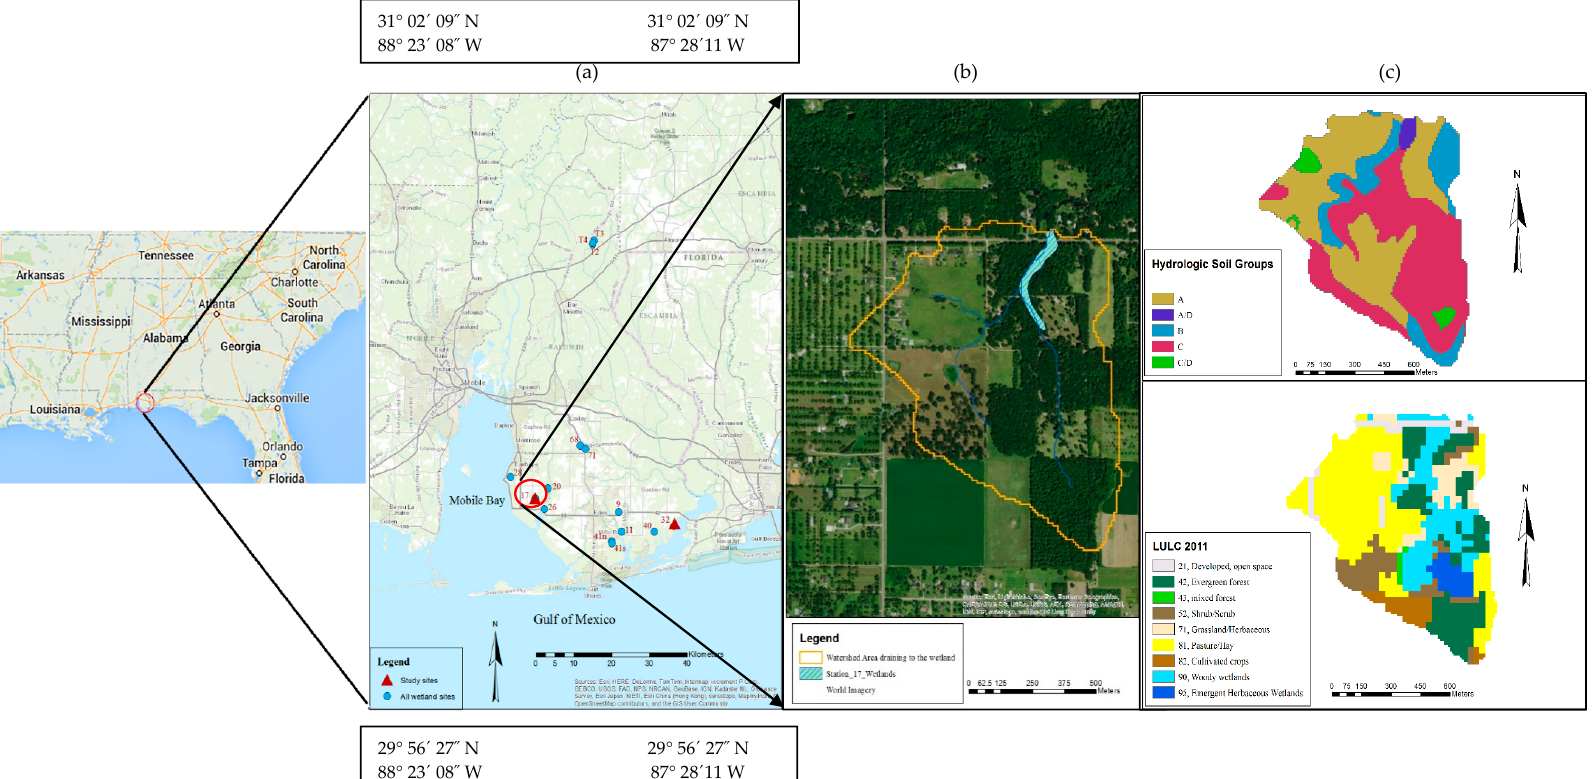
Figure 1. Study wetland with the delineated contributing watershed ( a , b ), and Hydrologic soil groups map and the land use/cover map based on 2011 National Land Cover Database (NLCD) for the study watershed ( c ).